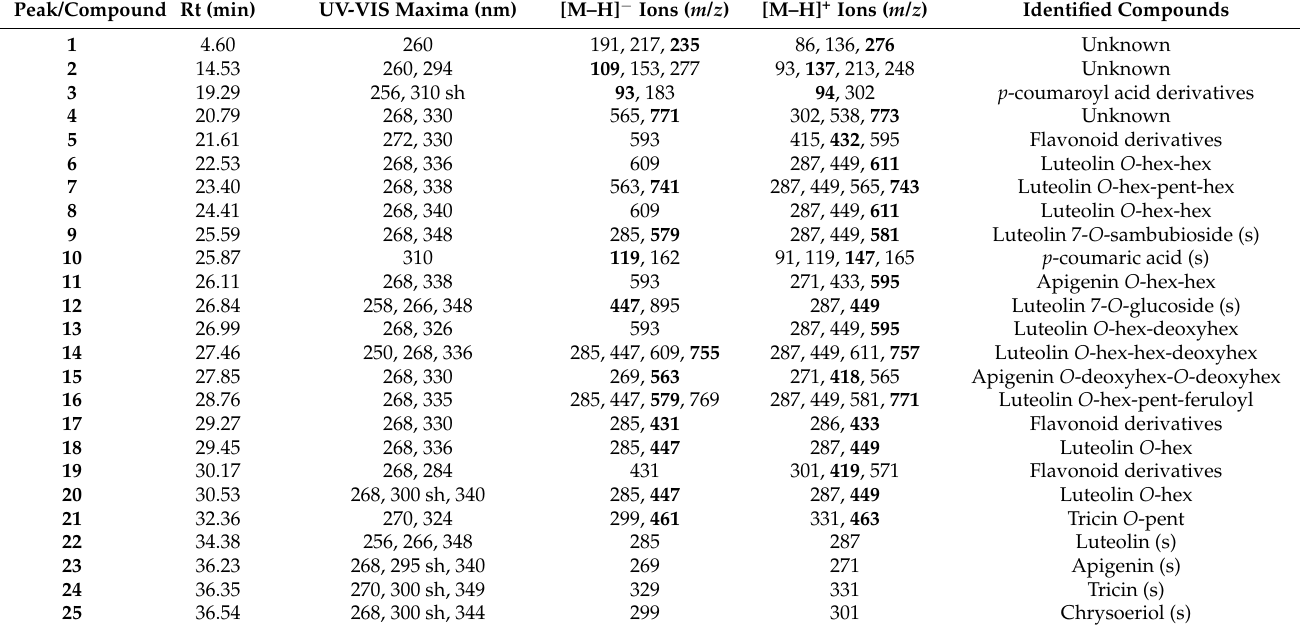
Table 1. Liquid chromatography–mass spectrometry (LC–MS) analysis of extracts/fractions ( JM1 – JM6 ) from Jasione montana . Peak/Compound Rt (min)